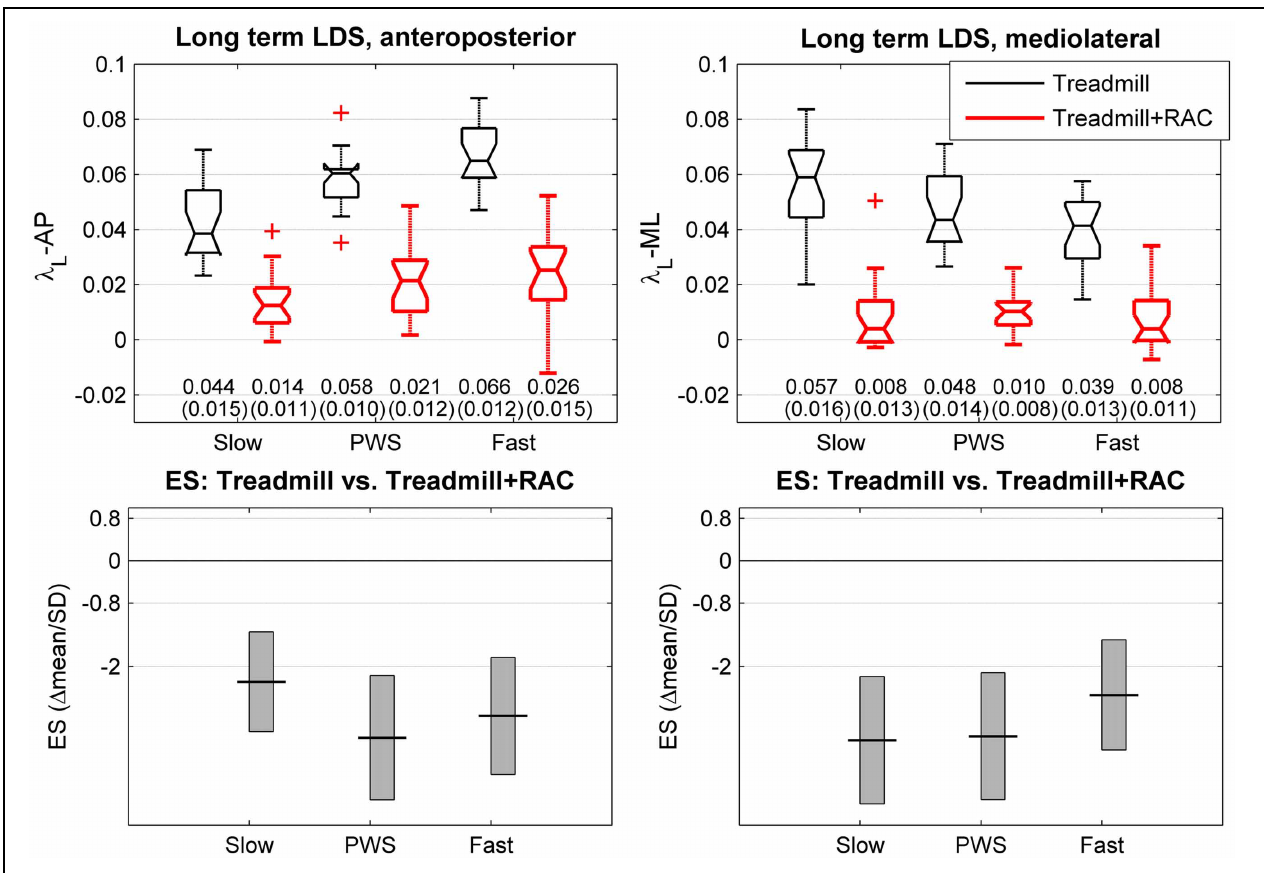
FIGURE 4 | Long-term local dynamic stability (LDS). Twenty healthy subjects walked 3 × 5min on an instrumented treadmill without (thin lines) and with Rhythmic Auditory Cueing [RAC, (metronome), thick lines at their preferred cadence for the given speed]. The center of pressure trajectory over 175 consecutive strides was analyzed along the anteroposterior and mediolateral axes. Long-term LDS is computed from the rate of logarithmic divergence among the 4 to 10th consecutive strides (finite time Lyapunov